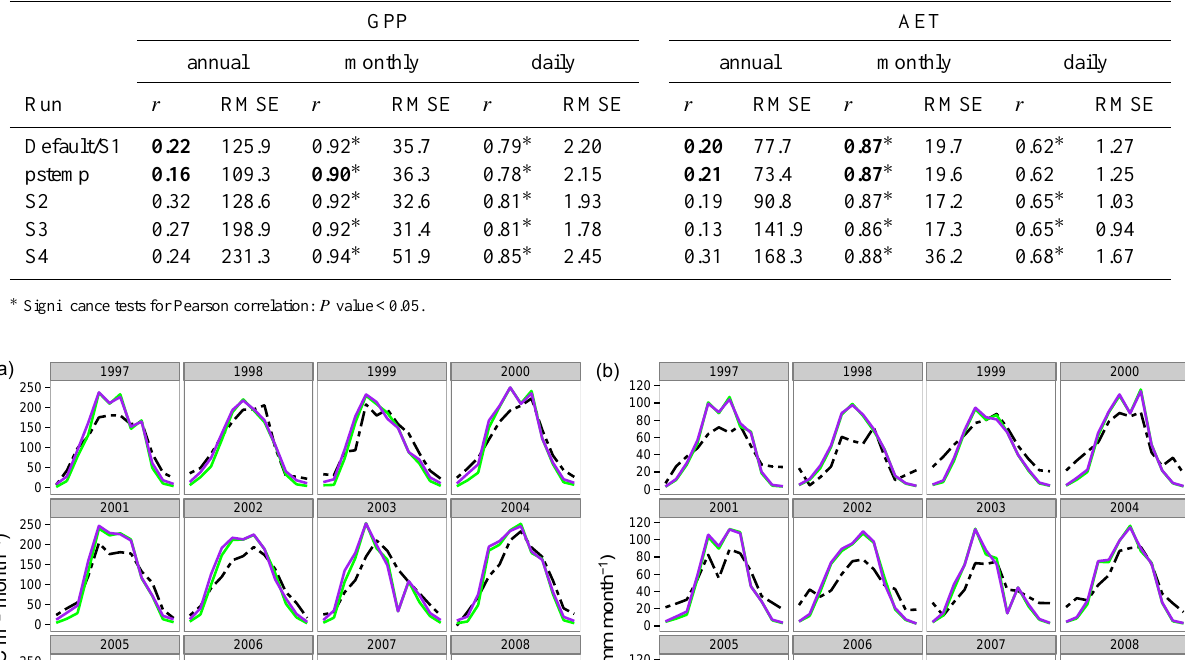
Table 3. Goodness-of-fit values for model scenarios S1–S4 and changed temperature response function, “pstemp”. Correlation coefficient ( r ) and RMSE for daily, monthly and annual data. Bold values represent data distributions that are identical using the Wilcoxon ranking test.